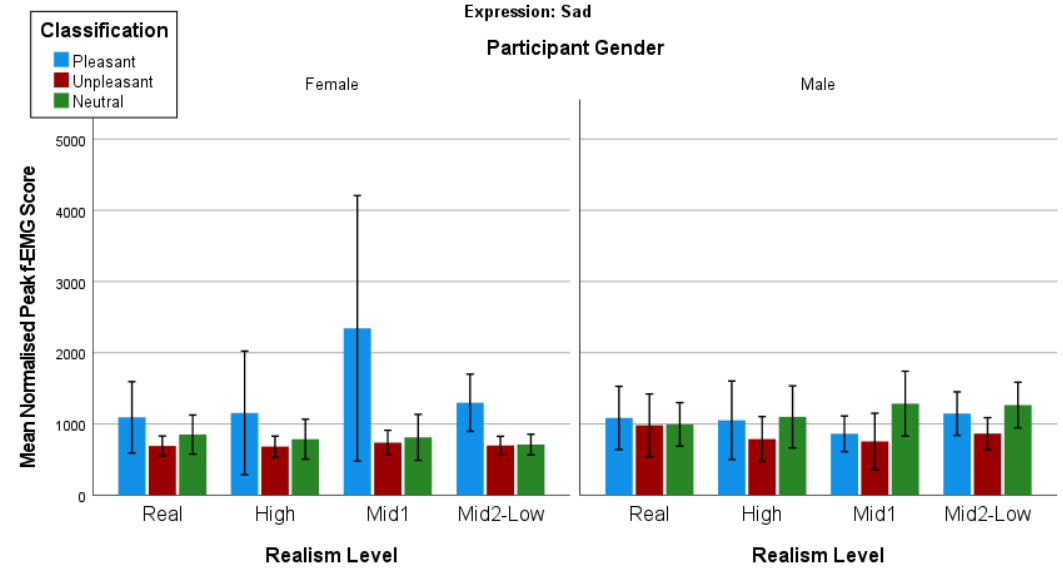
Figure 11. Mean valid responses by participant bio sex for avatars with sad expressions grouped by realism level.